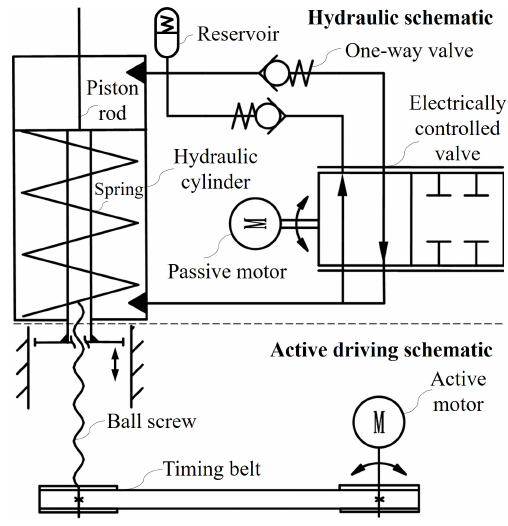
Figure 3. The complete schematic diagram of the hybrid actuation